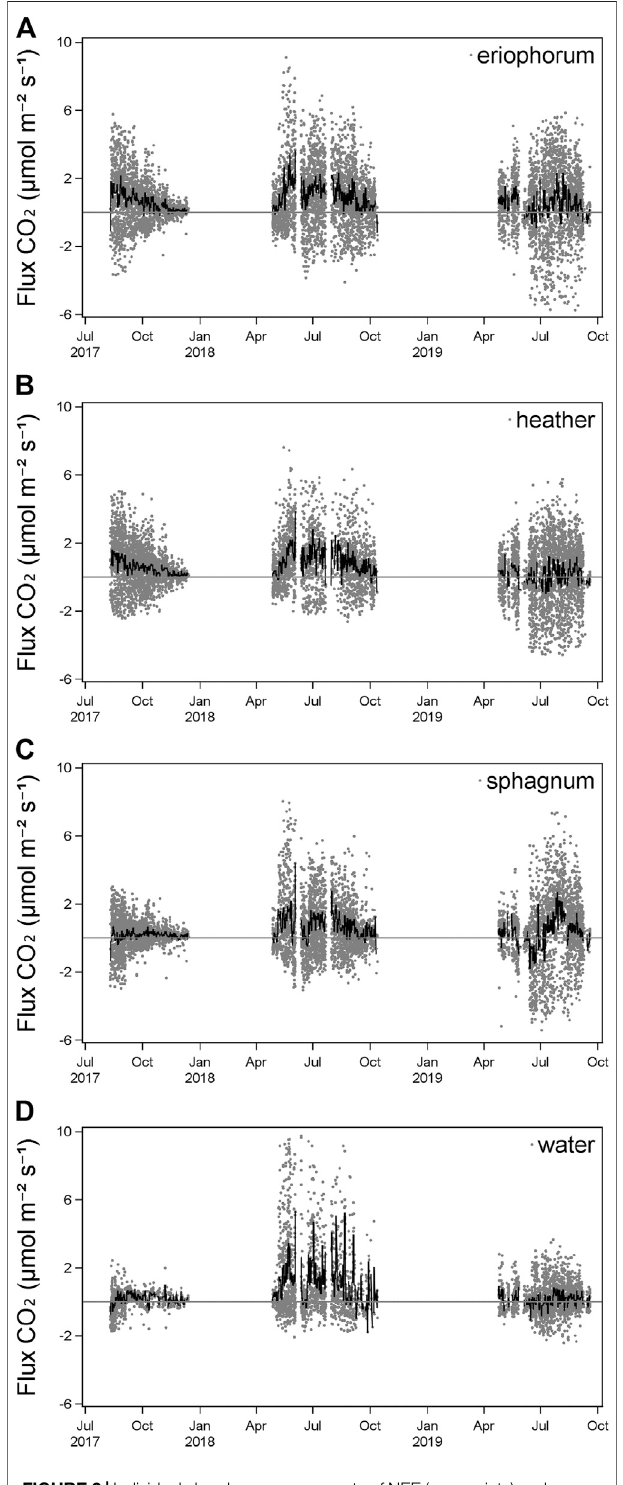
FIGURE 2 | Individual chamber measurements of NEE (gray points) and daily mean (n (cid:2) 6, black line) of each ecotype.